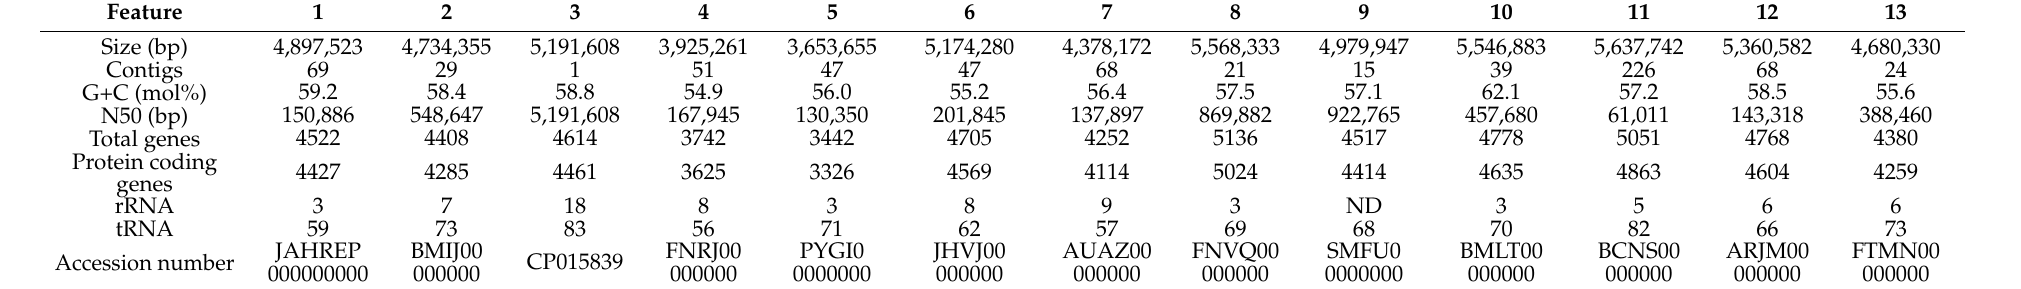
Table 1. General features of the genomes of strain D7 T and other species of the genus Marinobacterium